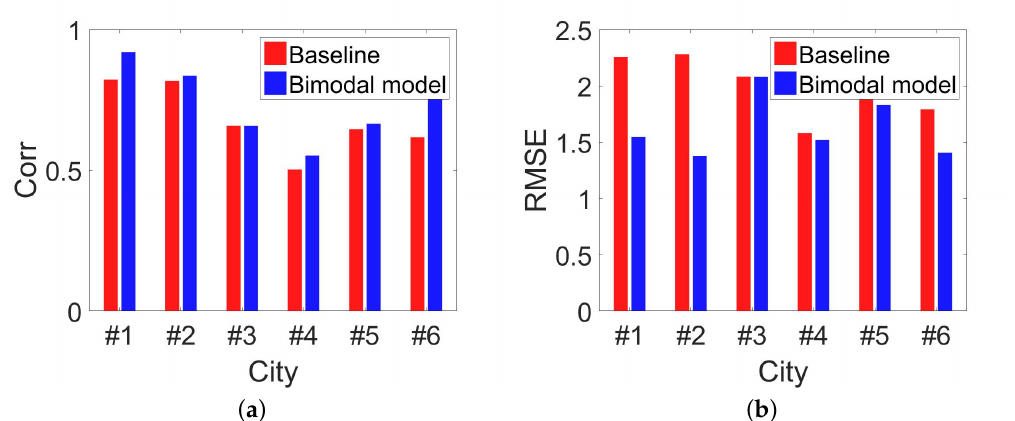
Figure 11. Only use mobility management signals and set time slot as 30 min which is 10 min in the main paper. ( a ) Correlation between estimated population with ground-truth among 6 cities by baseline model and bimodal model; ( b ) RMSE of estimated population for baseline model and bimodal model in 6